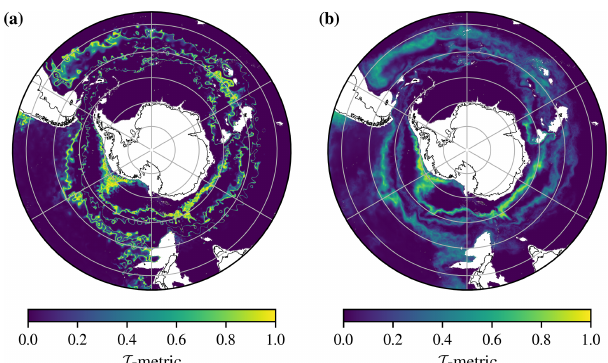
Figure 3. The magnitude of the I -metric highlights transitions be- tween coherent thermohaline regimes. Panel (a) is the I -metric for a single month (April 2012), and panel (b) is for the time aver- age of the B-SOSE iteration 106 dataset (60 months). Latitude lines are shown between 80 and 40 ◦ S every 10 ◦ , and longitude lines are shown every 60 ◦ . Animations showing month-to-month and in- terannual variability are available in the software release (Thomas,